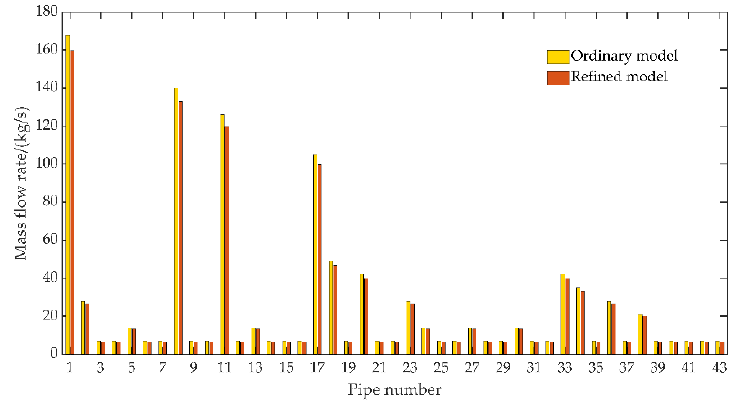
Figure 15. Mass flow rate of water under different models.